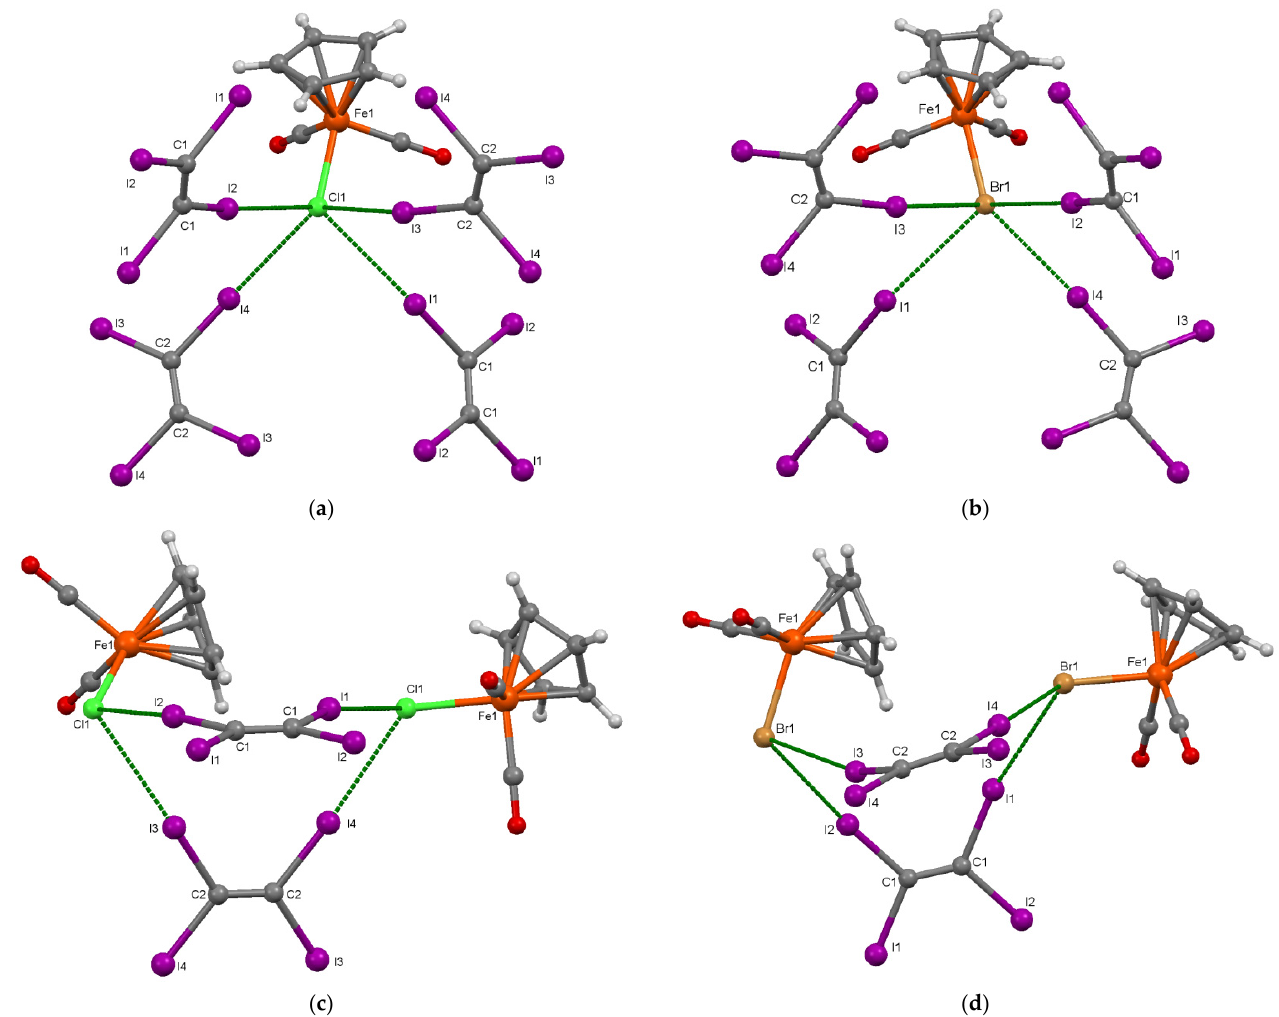
Figure 1. Fragments of the crystal structure of 1 ( a , c ) and 2 ( b , d ) showing the HaB-assisted supramolecular arrangement around [CpFe(CO) 2 X] molecules ( a , b ) and two independent C 2 I 4 molecules, bridging two [CpFe(CO) 2 X] ( c , d ). Selected interatomic distances in 1 (Å): Fe1-Cl1 2.295(2), Cl1 ⋯ I1 3.443(2), I3 ⋯ Cl1 3.382(2), Cl1 ⋯ I2 3.259(2), Cl1 ⋯ I4 3.261(2); Selected angles in 1 (°): Fe1-Cl1 ⋯ I1 114.06(8), Fe1-Cl1 ⋯ I2 113.40(8), Fe1-Cl1 ⋯ I3 100.64(8), Fe1-Cl1 ⋯ I4 130.31(9), C1-I2 ⋯ Cl1 168.7(3), C1-I1 ⋯ Cl1 166.4(3), C2-I3 ⋯ Cl1 162.8(3), C2-I4 ⋯ Cl1 175.7(3). Selected interatomic distances in 2 (Å): Fe1-Br1 2.430(1), Br1 ⋯ I1 3.5598(7), Br1 ⋯ I2 3.3717(7), Br1 ⋯ I3 3.4517(8), Br1 ⋯ I4 3.3398(7). Selected angles in 2 (°): Fe1-Br1 ⋯ I1 112.56(3), Fe1-Br1 ⋯ I2 112.13(3), Fe1-Br1 ⋯ I3 97.03(3), Fe1-Br1 ⋯ I4 134.93(3), C1-I1 ⋯ Br1 164.3(2), C1-I2 ⋯ Br1 170.2(2), C2-I3 ⋯ Br1 161.3(2), C2-I4 ⋯ Br1 176.0(2).